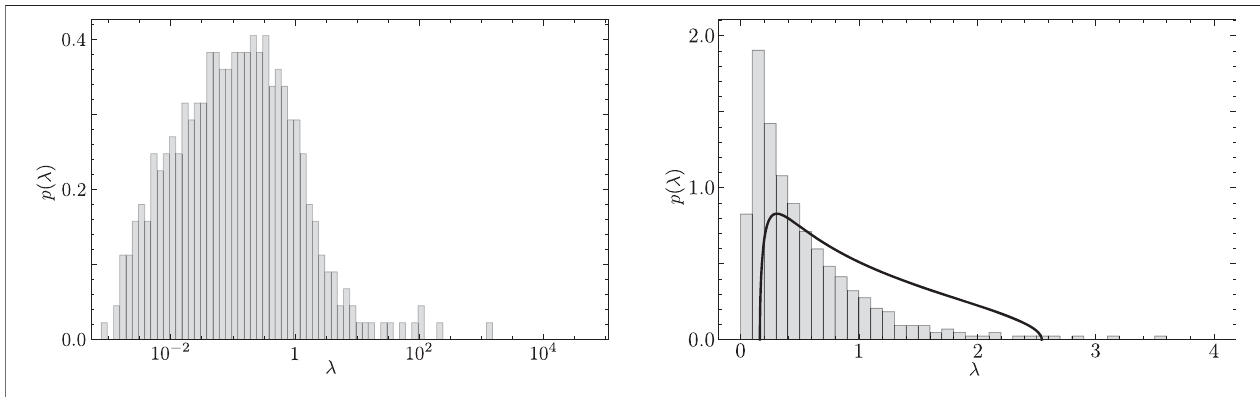
FIGURE8|(Left) Distribution p ( λ ) ofeigenvalues λ oftheempiricalequal-timecross-correlationmatrix. (Right) Empiricallyobtaineddistribution p ( λ ) ofeigenvalues λ in the range of small eigenvalues. The solid line is the Mar ˇ cenko-Pastur distribution derived under RMT as the theoretical curve given by Eq. 5 with Q (cid:2) 2 N / T .